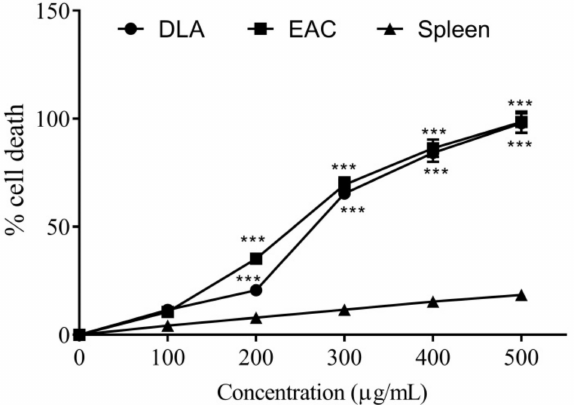
Figure 2. In vitro cytotoxicity of different concentrations of methanolic extract of O. indicum Vent. root bark (OIM) on DLA and EAC cell lines and normal spleen cells. *** Indicates a significant variation with p < 0.001 with the cytotoxicity in spleen cells.